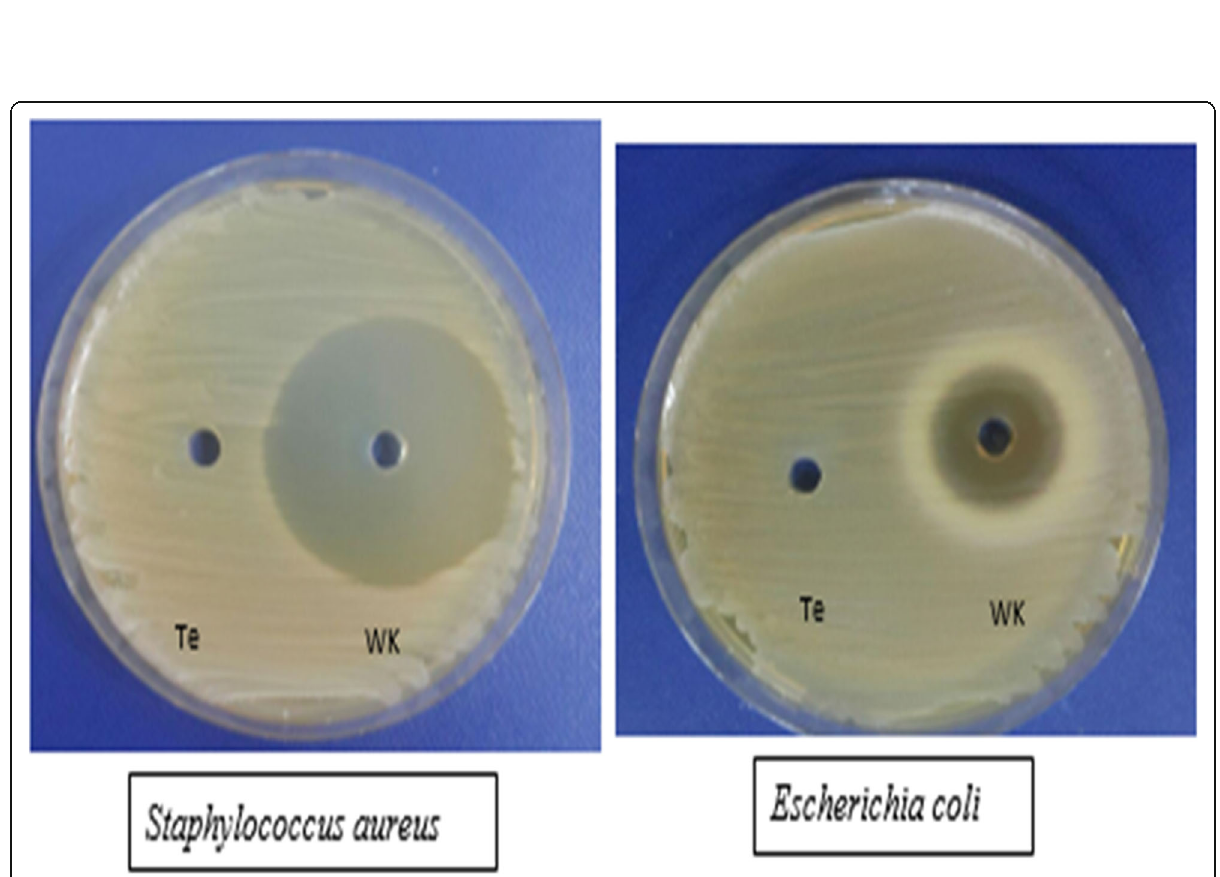
Fig. 3 Antimicrobial activity of TK for Torulaspora delbrueckii against Staphylococcus aureus and E.coli at a concentration of 200 mg/ml